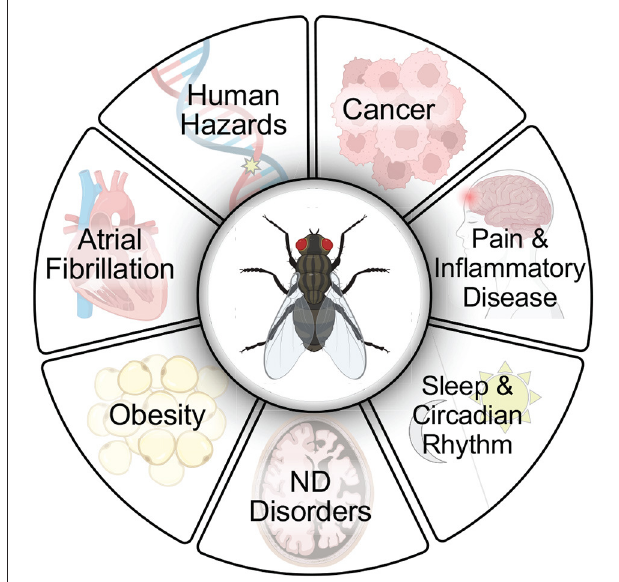
FIGURE 1 | Flies have extraordinary utility for use in drug screening protocols to advance discoveries for human health. Flies have been used extensively in drug discovery, in large part due to their ease of use and relevance to human disease models ( Fernández-Hernández et al., 2016; Su, 2019). Small molecules have been identified in screens with relevance to several human disease conditions including cancer (Willoughby et al., 2013; Yadav et al., 2016; Bangi, 2019; Al Outa et al., 2020 ), pain and inflammatory disease ( Grimes et al., 2020), sleep and circadian rhythm (Nall and Sehgal, 2013; Wang et al., 2020 ), neurodegenerative (ND) disorders including Alzheimer’s disease (Hannan et al., 2016; Elovsson et al., 2021), Parkinson’s disease (Sanz et al., 2021), Huntington’s disease (Sarkar et al., 2007; Schulte et al., 2011), Lysosomal storage disorders ( Rigon et al., 2021), Alexander disease (Wang et al., 2016 ), Friedreich’s disease (Seguin et al., 2015), Fragile X syndrome (Chang et al., 2008), Ataxia-telangiectasia (Rimkus and Wassarman, 2018), obesity ( Gasque et al., 2013), atrial fibrillation (van Marion et al., 2019), and in human hazard identification (testing potential genotoxins such as food, dietary supplements, cosmetics, drugs, pesticides, herbicides, and nanoparticles) (Barik and Mishra, 2019; Pitchakarn et al., 2021). Created with